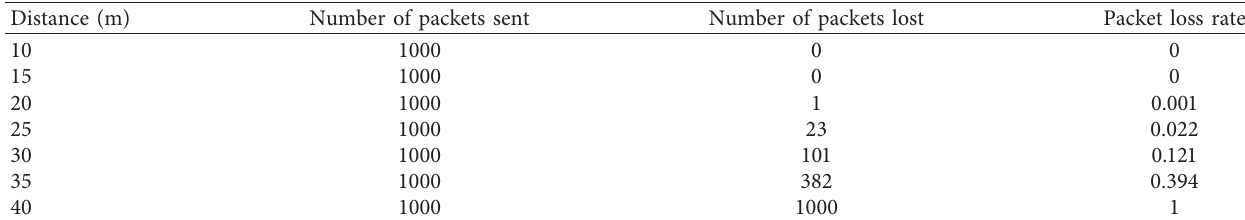
Figure 23: Device for sensing and data gathering. Table 3: Test results of communication quality.